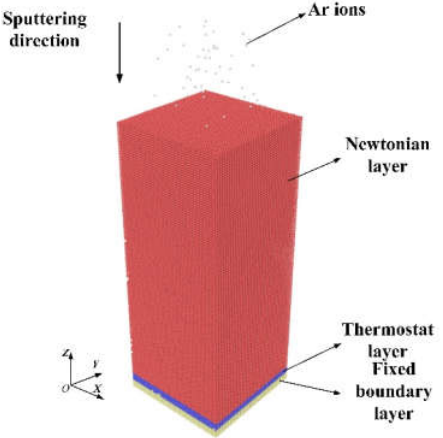
Figure 1. MD model of ion beam sputtering of single crystal aluminum.